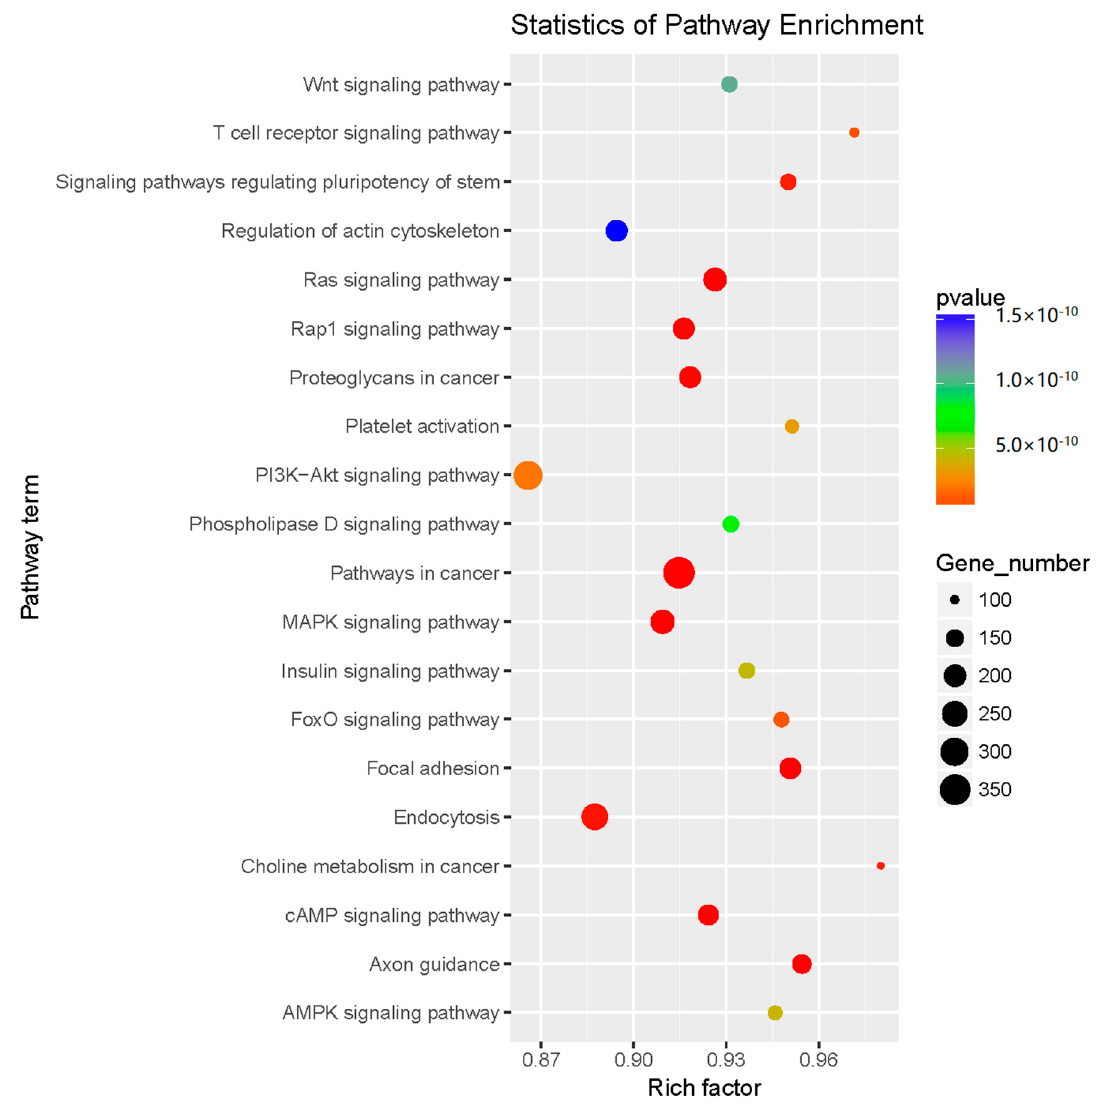
Figure 3. Pathway enrichment of the predicted targets of the differentially expressed miRNAs.